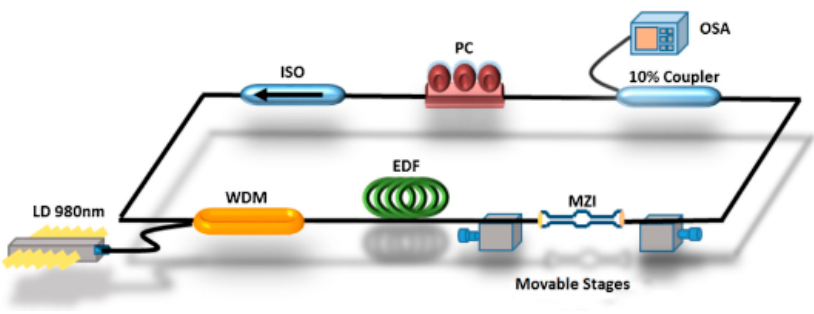
Figure 6. Experimental set up of strain sensor based on FRL.